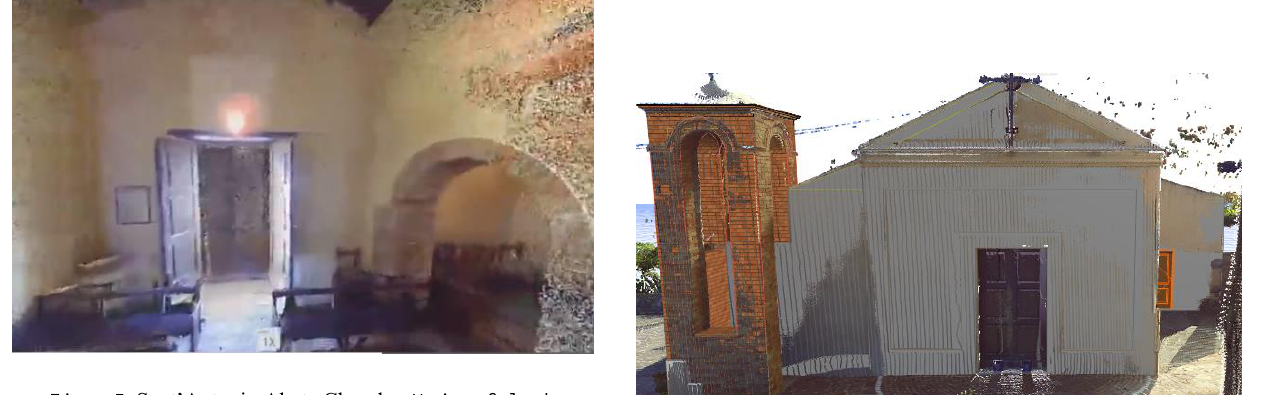
Figure 5. Sant’Antonio Abate Church – Union of clouds